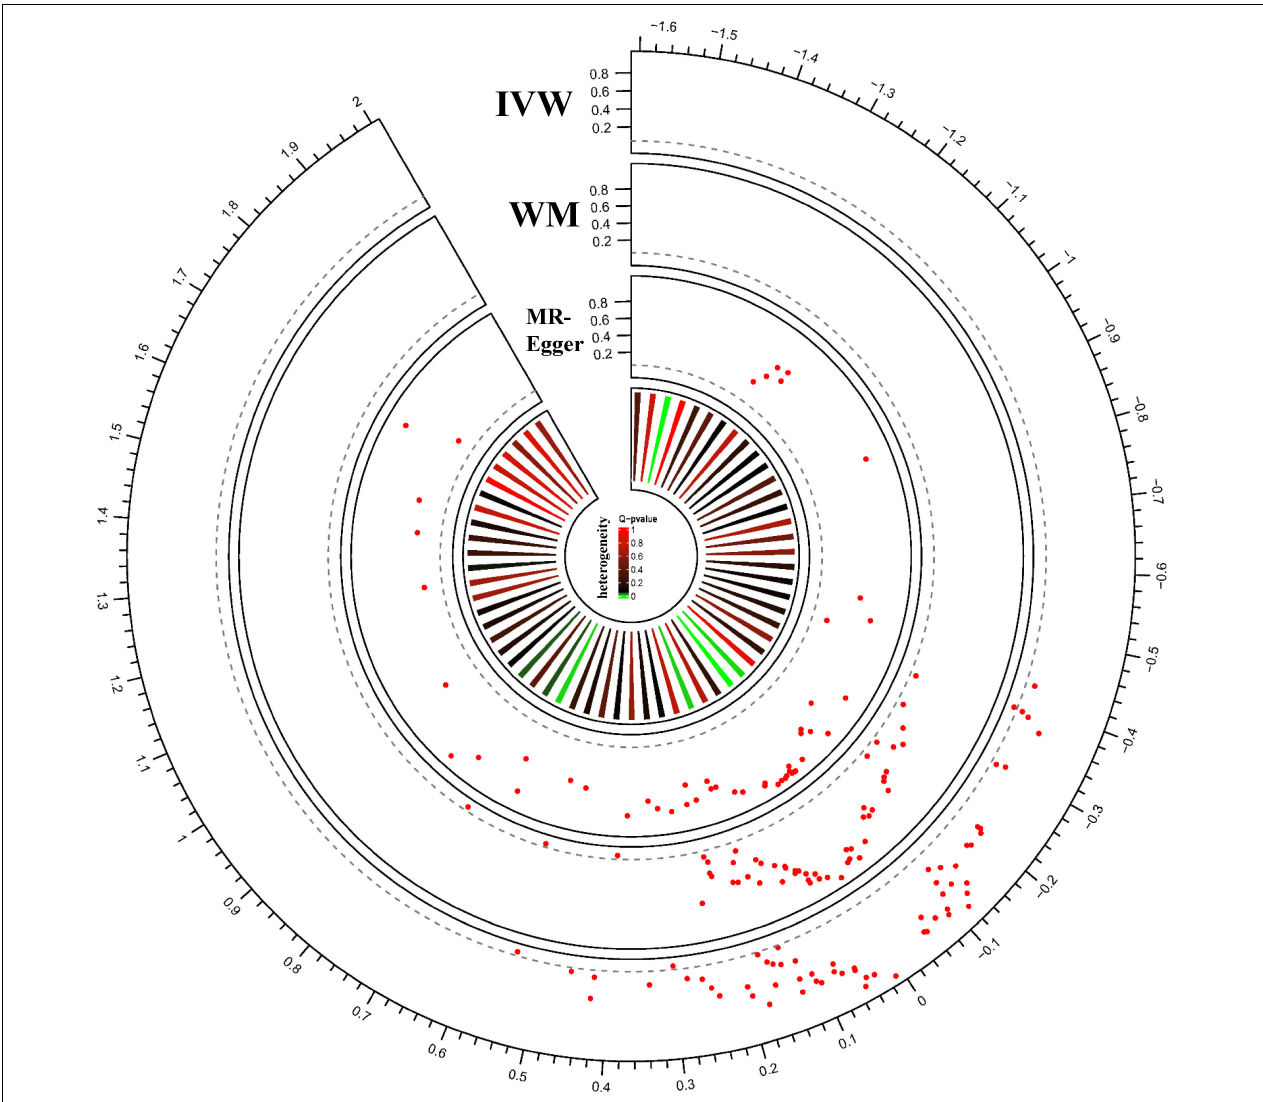
FIGURE 3 | MR results for ROI-Glaucoma associations. Each radius represents one ROI measurement. From outer to inner layer: MR results analyzed with IVW; MR results analyzed with WM; MR results analyzed with MR-Egger; heterogeneity of each ROI measure. The red dot represents the ROI-Glaucoma relation. The X-axis shows the beta value, and Y-axis shows the p -value. The dotted gray line indicated the nominal p threshold (0.05).